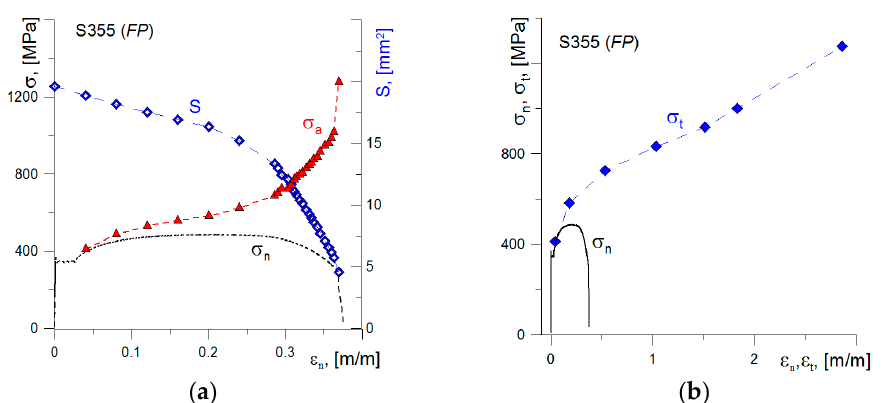
Figure 8. ( a ) Reduction in the specimen cross-sectional area S and increase in stresses σ a during loading; ( b ) the stress-strain plots for nominal and true values.